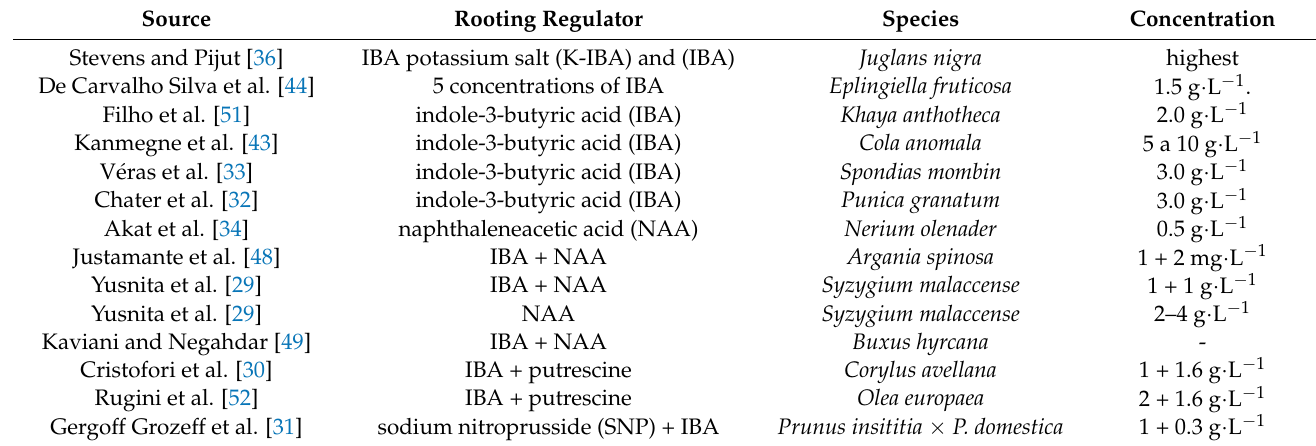
Table 1. Overview of different rooting regulators used in rooting of hardwood